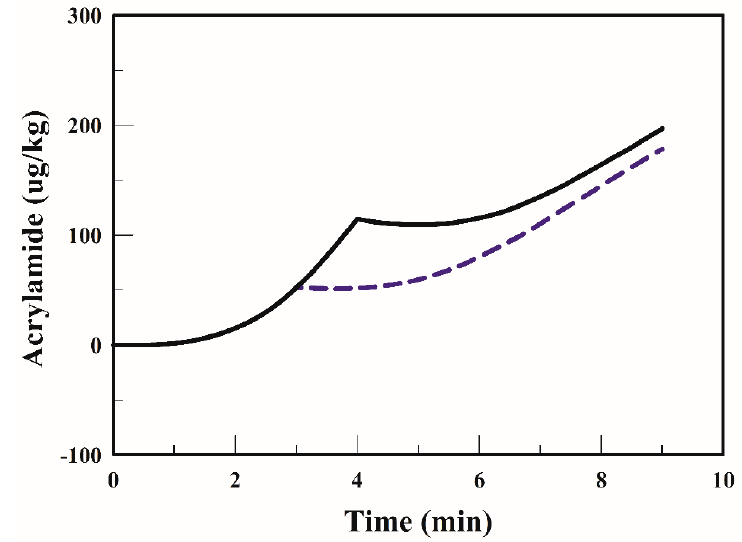
Figure 7. Profiles of acrylamide formation rate in the strip when fried with the temperature-step frying approach at 170 °C for 3 min (dotted line) and for 4 min °C (solid line).